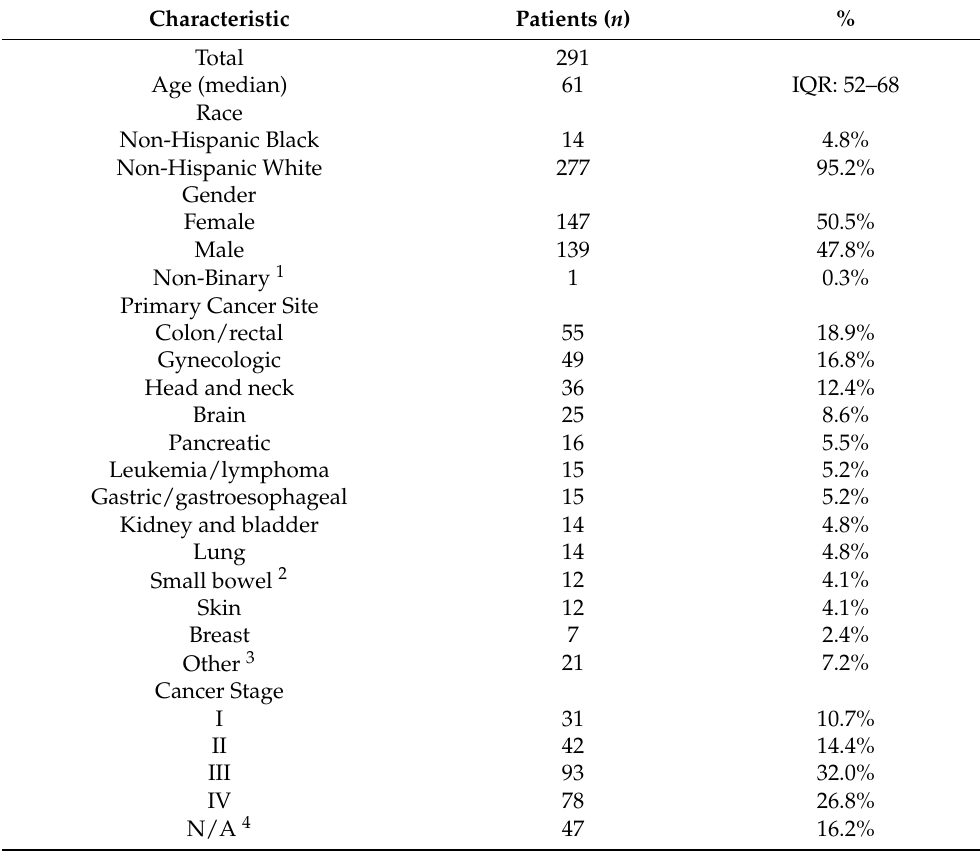
Table 1. Patient demographics and disease characteristics.